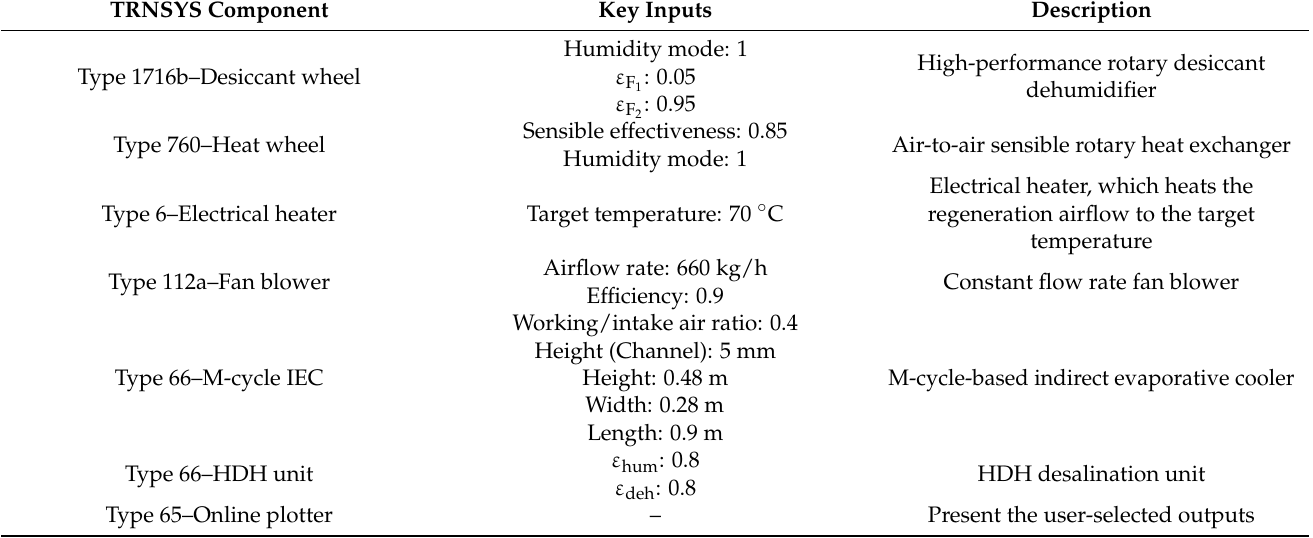
Table 1. Descriptions of the main TRNSYS elements used in the